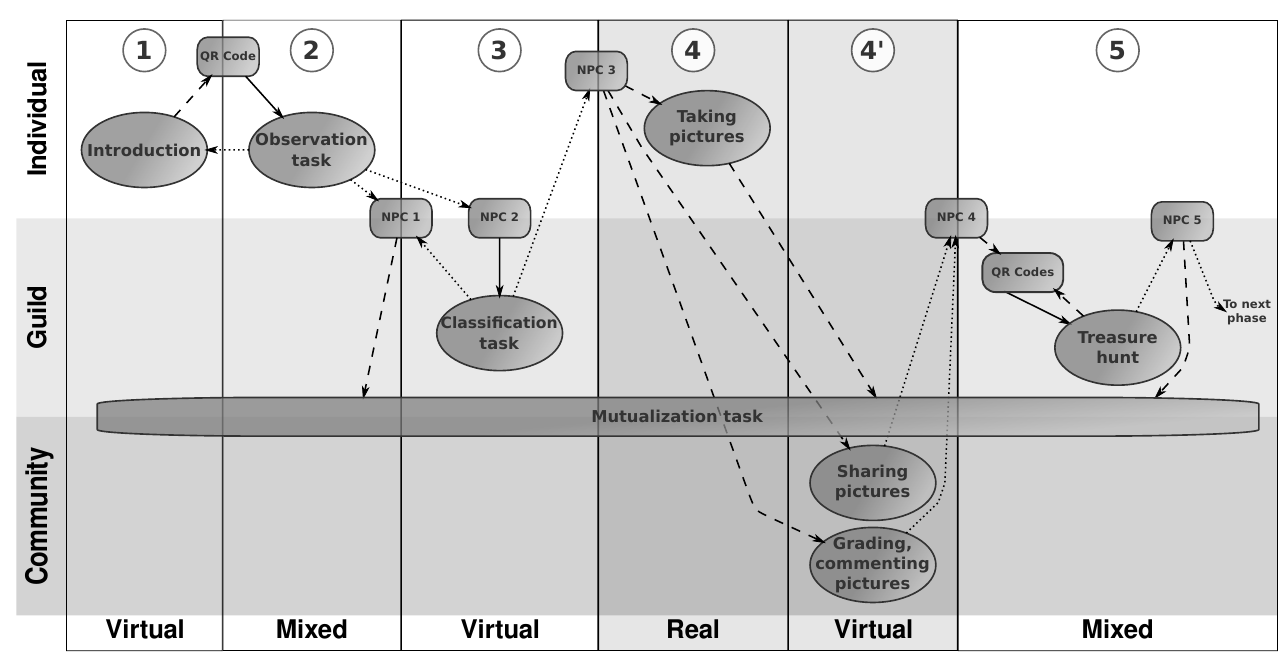
Figure 1. The game scenario displaying activity (real, mixed or virtual) and actor (individual, guild or community)